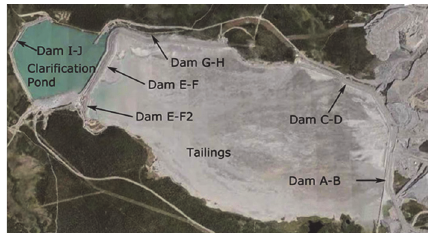
Figure 2: Aerial view of Aitik tailings dam and impoundment